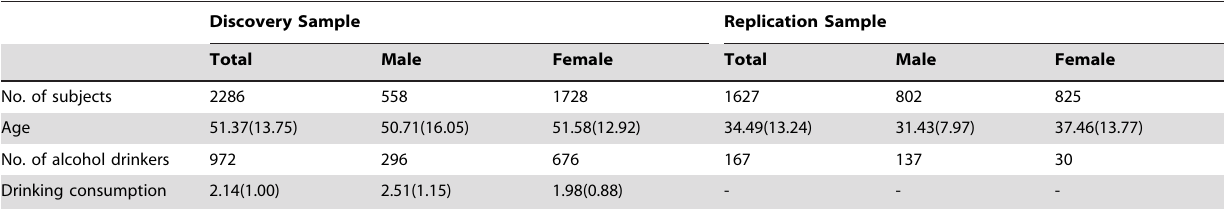
Table 1. Basic characteristics of the study subjects.